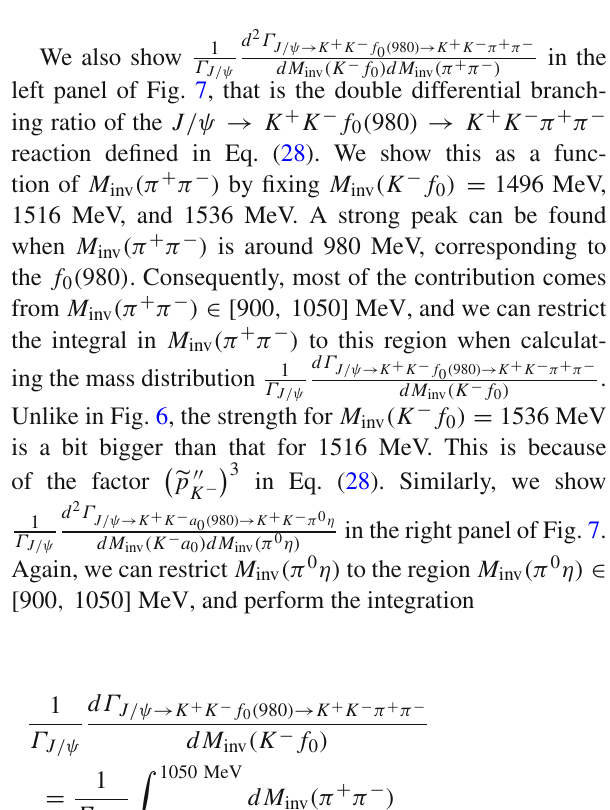
= 981 MeV, d m f 0